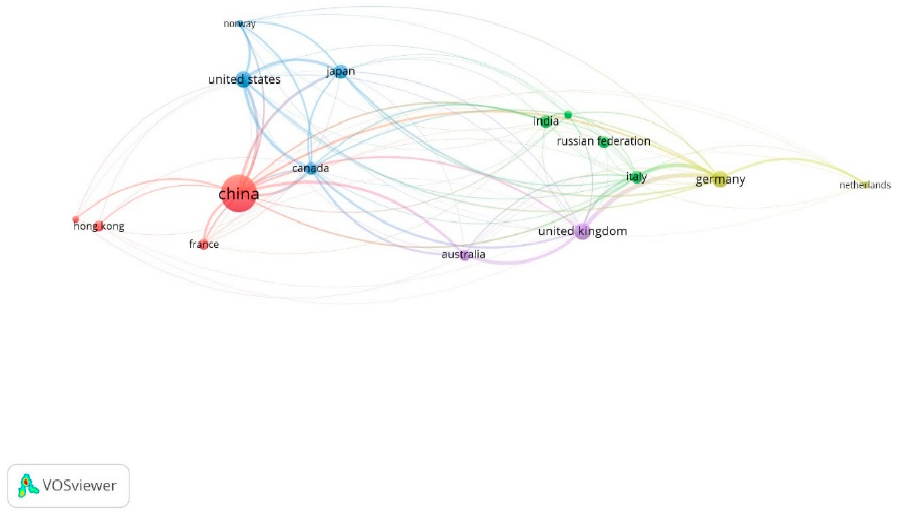
Figure 1. BC of countries (line 174).